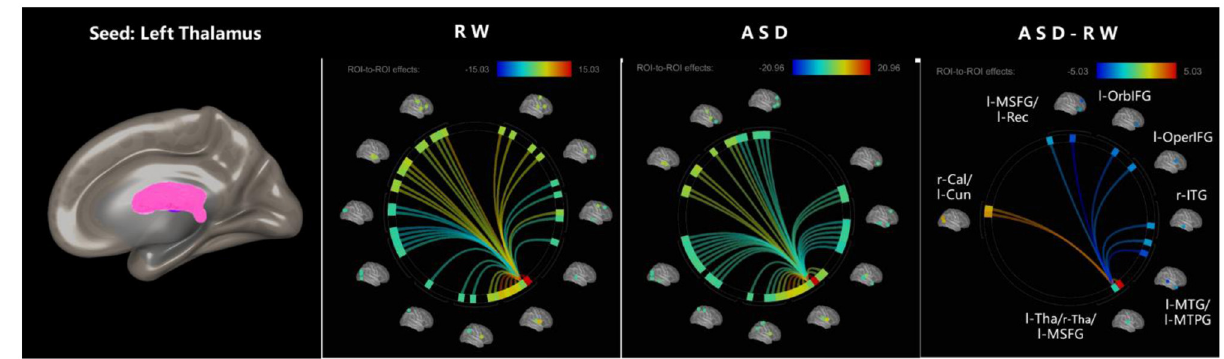
Frontiers in Neurology |